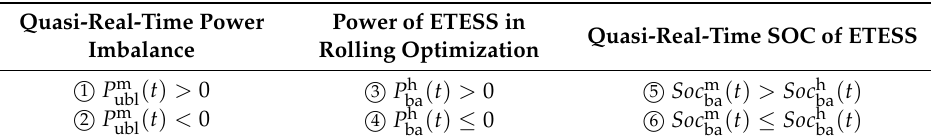
Table 1. Quasi-real-time coordinated control criterion